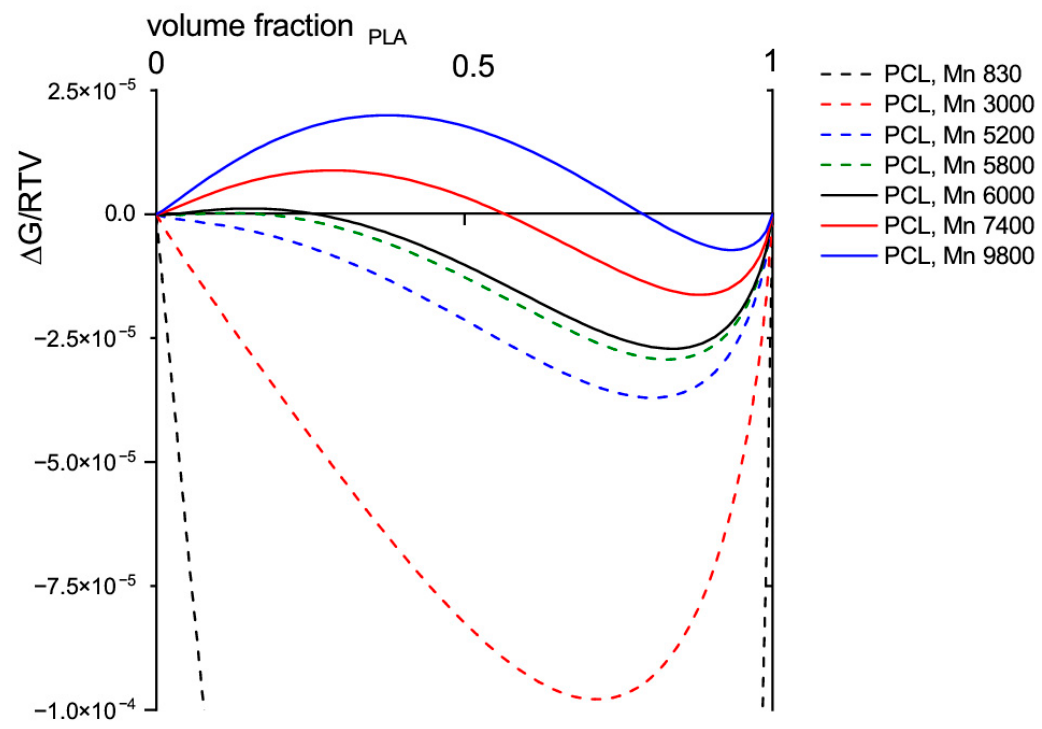
Figure 1. Gibbs free energy of mixing of PLLA (molecular weight M n = 80,000 g · mol − 1 ) with PCL oligomers of di ff erent molecular weight M n